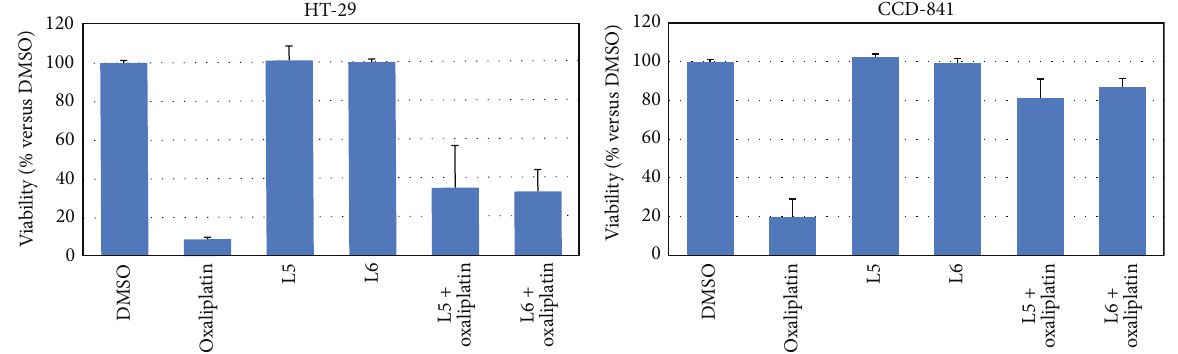
Figure 2: Viability of 24 h pretreated (with 50 𝜇 M of L5 ⋅ HCl or L6 ⋅ HCl) human tumor colon (HT-29) and human nontumor colon (CCD-841) cell lines prior to oxaliplatin administration (50 𝜇